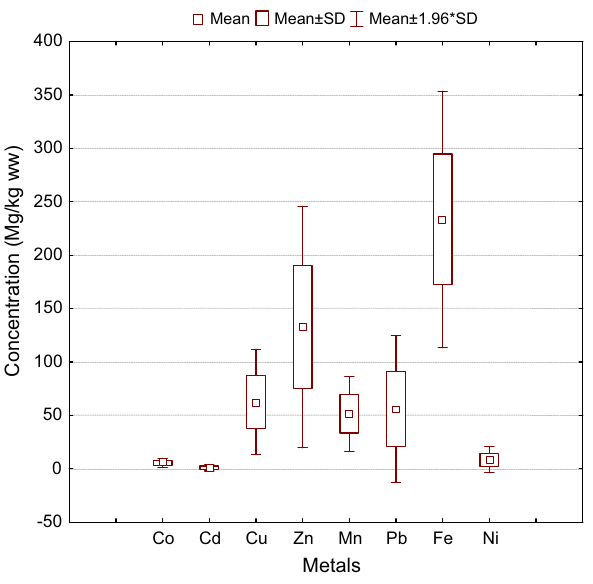
Fig. 4 Box and whisker plot showing variation heavy metals concen- trations in T. fuscatus